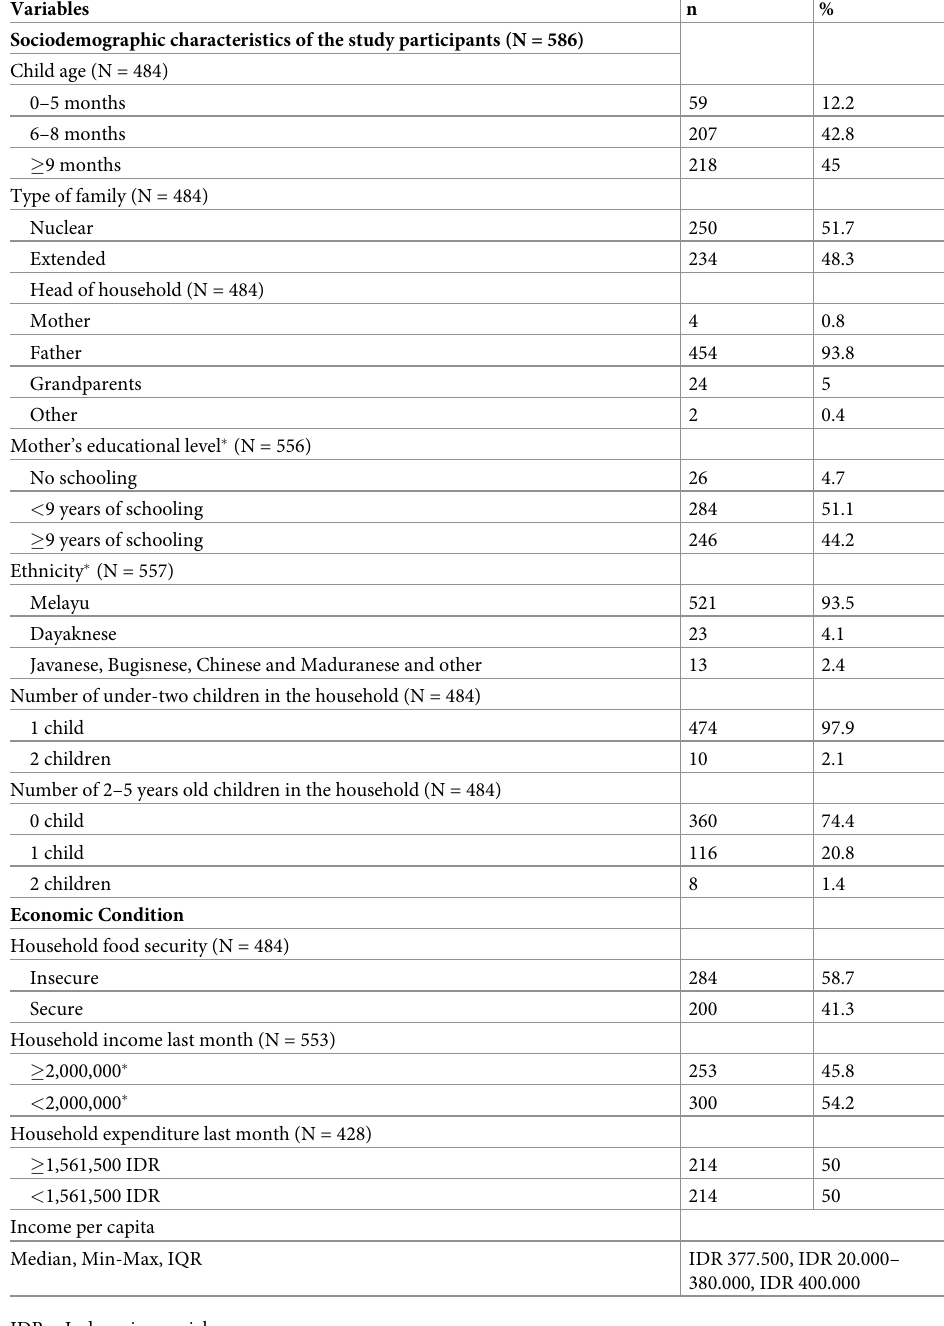
Table 2. Sociodemographic characteristics and economic conditions of study participants. Variables n % Sociodemographic characteristics of the study participants (N =